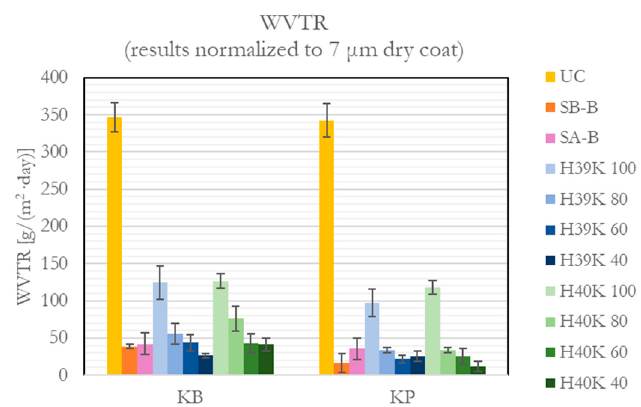
Figure 6. WVTR values for the uncoated (UC), commercial (SA-B and SB-B), and experimental dispersion coatings.